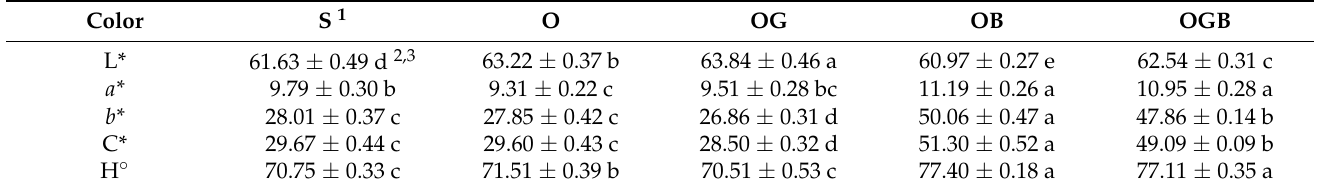
Table 4. Color of muffins containing fortified-oleogel as a shortening